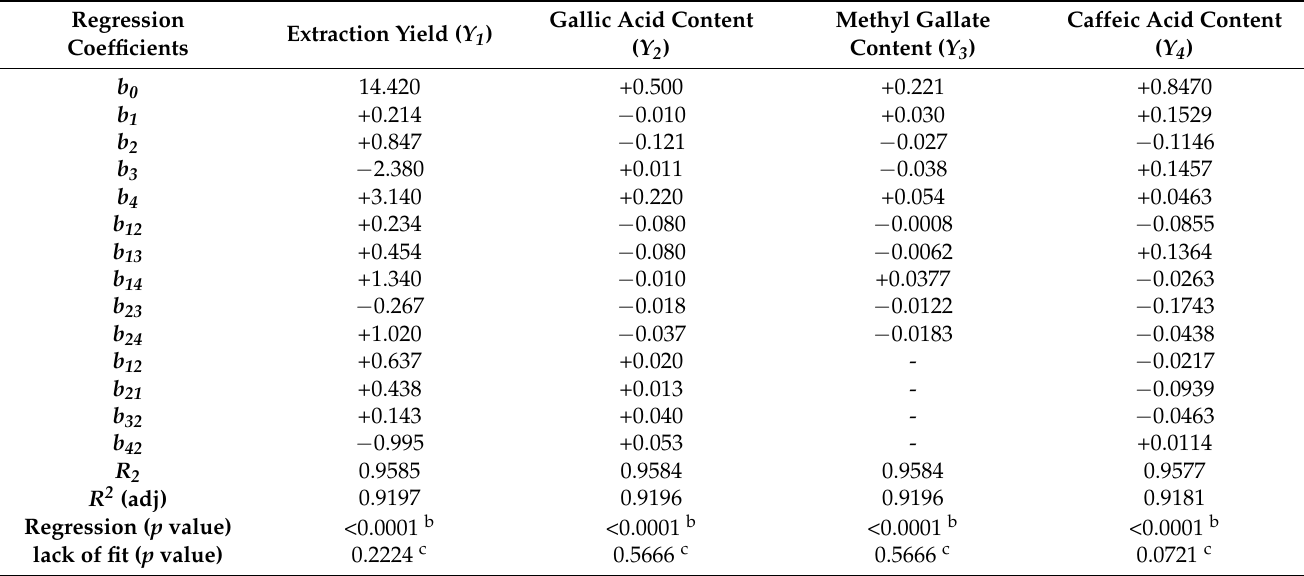
Table 2. Regression coefficients, R 2 , adjusted R 2 , probability values, and lack of fit for two dependent variables a